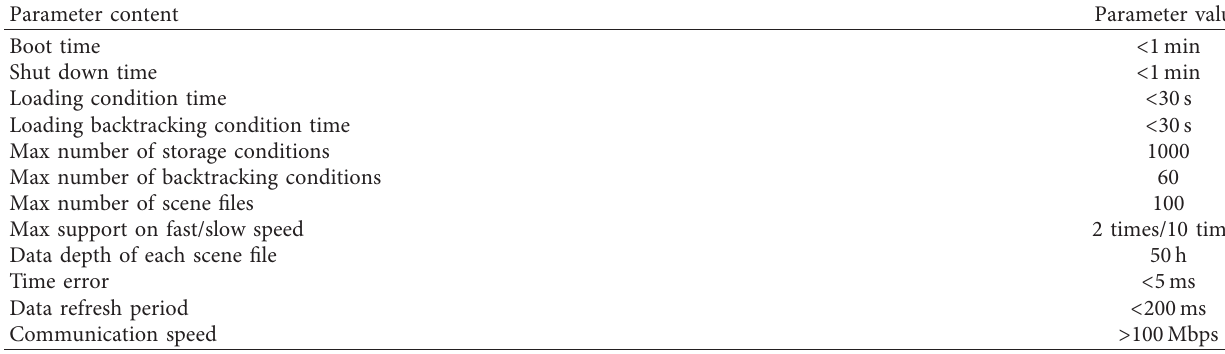
Table 1: Performance parameters of the SVDU simulator.